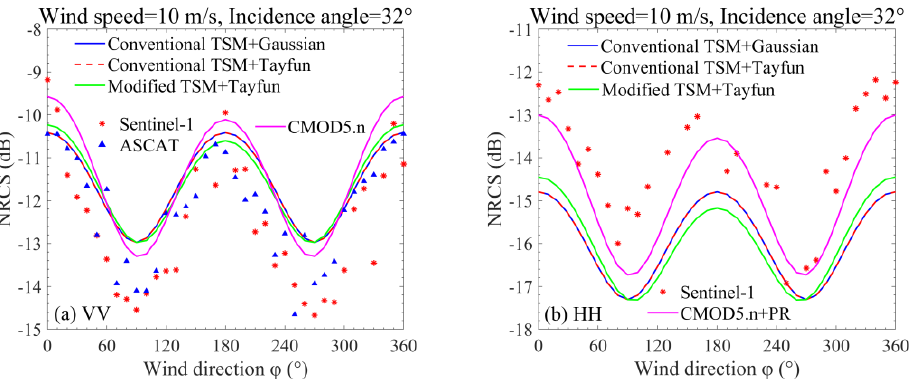
Figure 10. The average NRCSs based on conventional TSM + Gaussian sea surface, conventional TSM + Tayfun sea surface, and modified TSM + Tayfun sea surface and their comparison with reference data as functions of the wind direction at a 10 m/s wind speed and 32° incidence angle under VV and HH polarizations. Curves and symbols are the same as those in Figure 8. ( a ) The average NRCSs as functions of the wind direction at a 10 m/s wind speed and 32° incidence angle under VV polarization; ( b ) the average NRCSs as functions of the wind direction at a 10 m/s wind speed and 32° incidence angle under HH polarization.